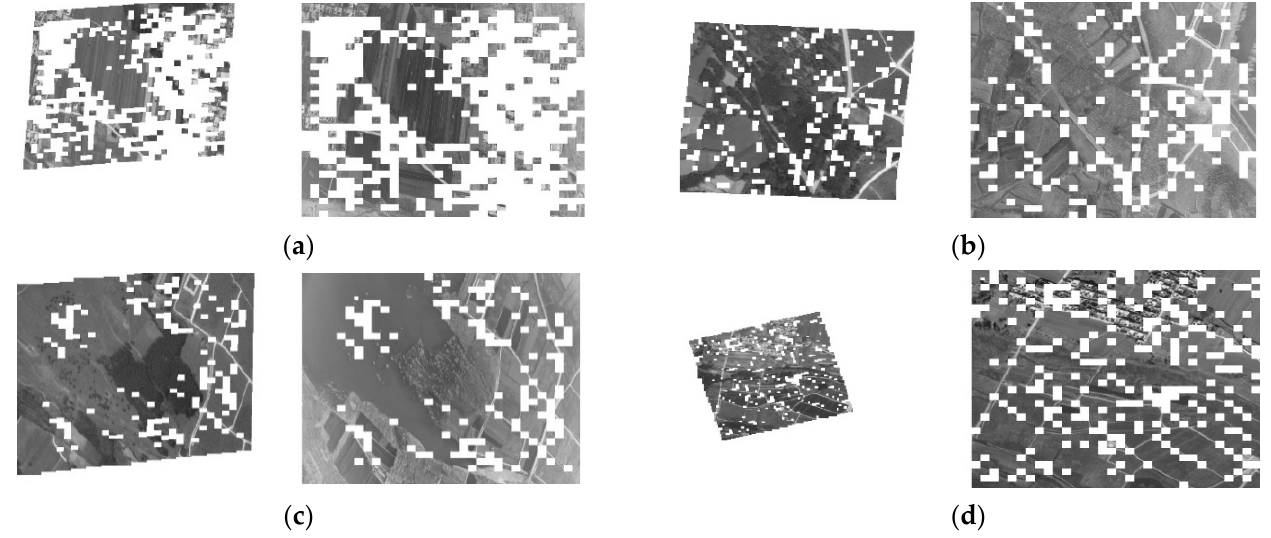
Figure 8. Results of the feature-sparse region detector: ( a ) image pair a, ( b ) image pair b, ( c ) image pair c, and ( d ) image pair d.